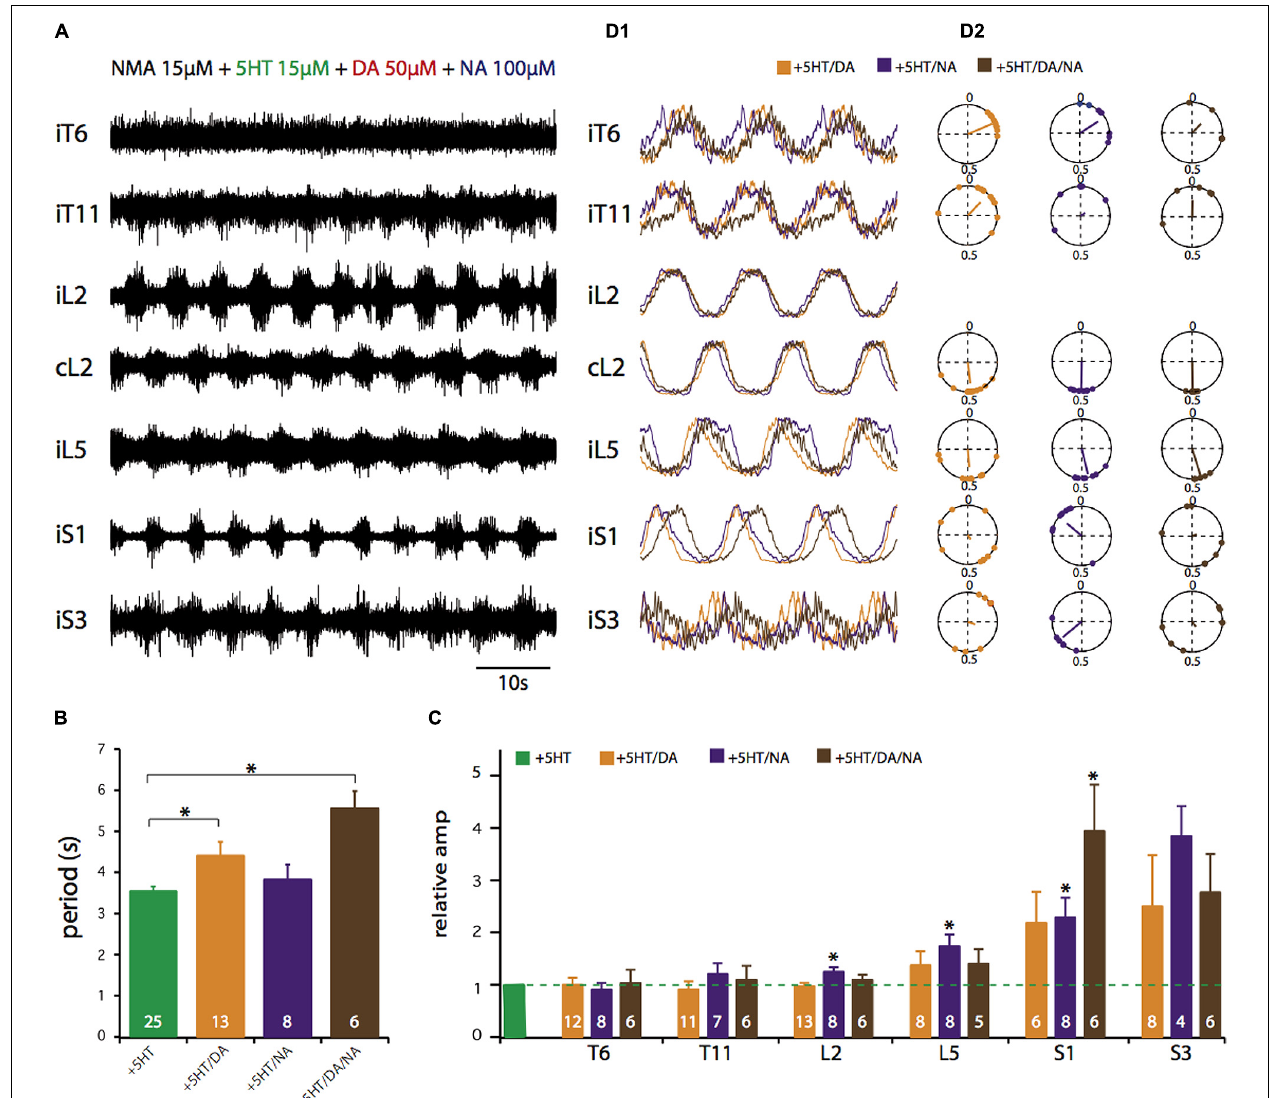
FIGURE 4 | Control of activity phase relationships by various combinations of NMA and 5-HT/DA/NA. (A) Simultaneous recordings of seven ventral roots in the presence of all four drugs. (B) Plots of mean cycle periods under various drug combinations. (C) Plots of mean relative amplitude changes normalized to the amplitude observed in the NMA/5-HT condition (green bar). (D1) Averaged and replicated cycles during locomotor-like activity